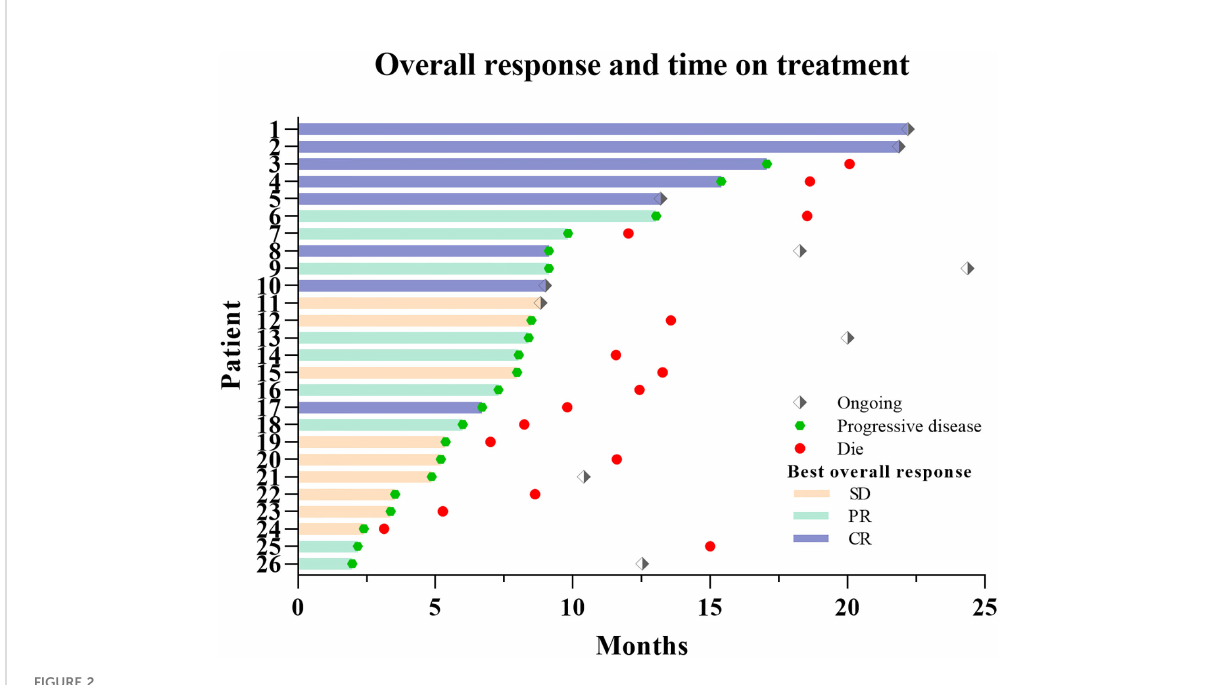
FIGURE 2 Follow-up of all recurrent glioblastoma (rGBM) patients.